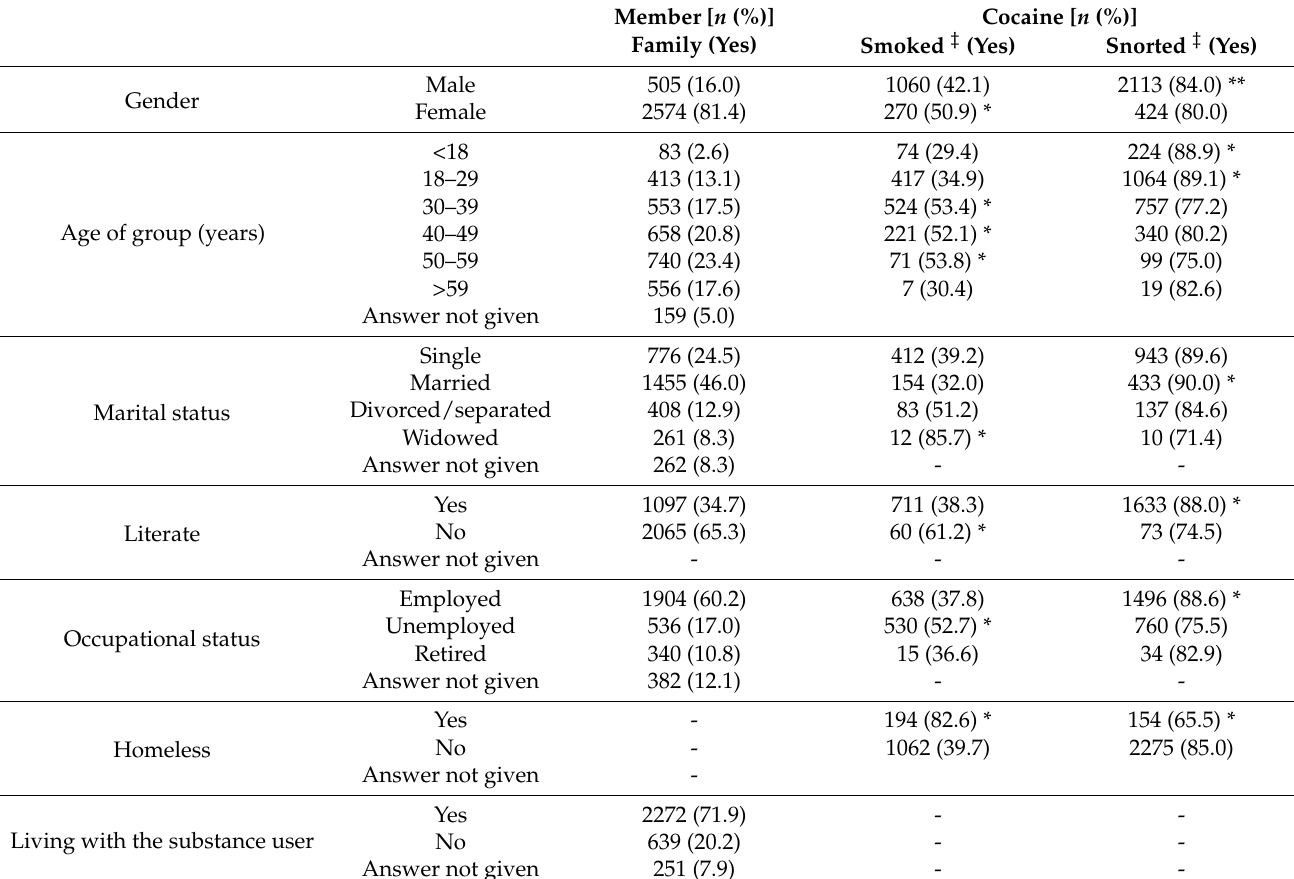
Table 1. Sociodemographic characteristics of family members, drug users and the distribution of cocaine (smoked or snorted) in the sample. Member [ n